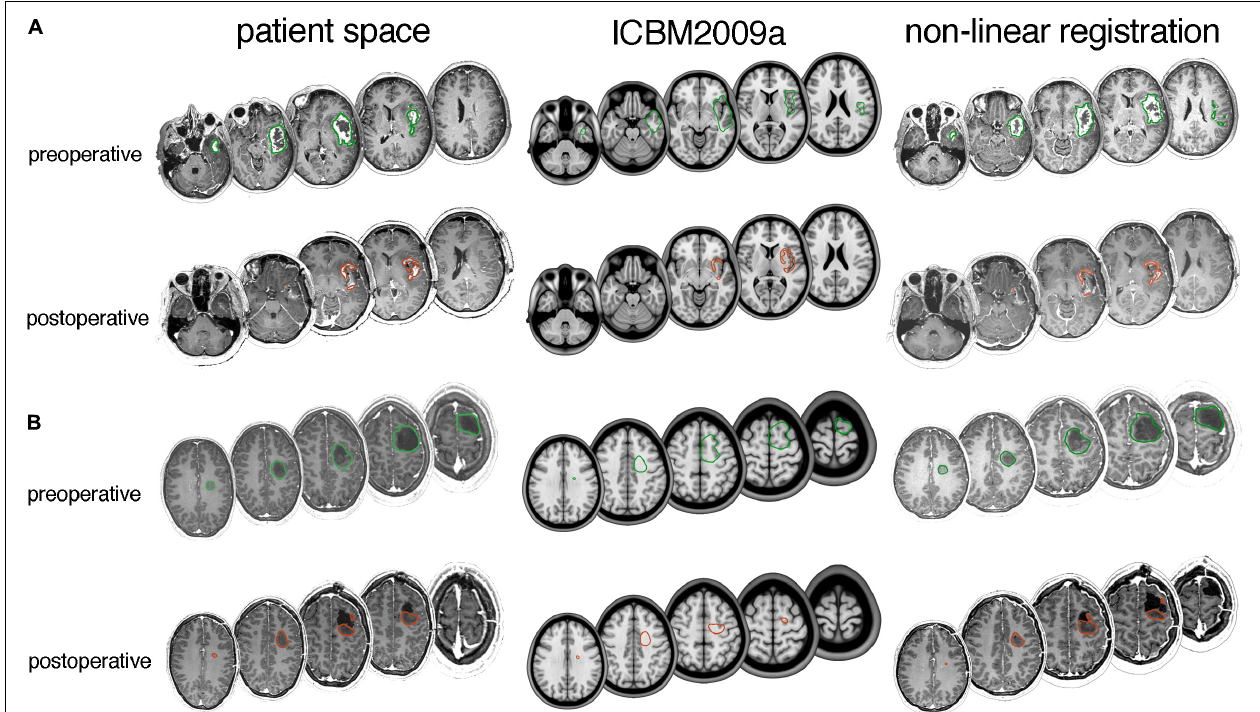
FIGURE 4 | Typical tumor registration examples for (A) glioblastoma and (B) lower-grade glioma. Axial slices with delineated pre- and post-operative tumor are shown in patient space (left), ICBM2009a space (middle) and after non-linear transformation by the DARTEL registration package (right). (A) A 66-year-old female with a 46.4 mL preoperative tumor and 3.8 mL postoperative tumor. Dice scores are 0.67 for preoperative tumor and 0.43 for postoperative tumor, and modified Hausdorff distances are 4.1 and 2.5 mm, respectively. (B) A 34-year old male with a 25 mL preoperative tumor and 12 mL postoperative tumor. Dice scores are 0.62 for pre-operative tumor and 0.55 for postoperative tumor, and modified Hausdorff distances are 4.5 and 4.2 mm,